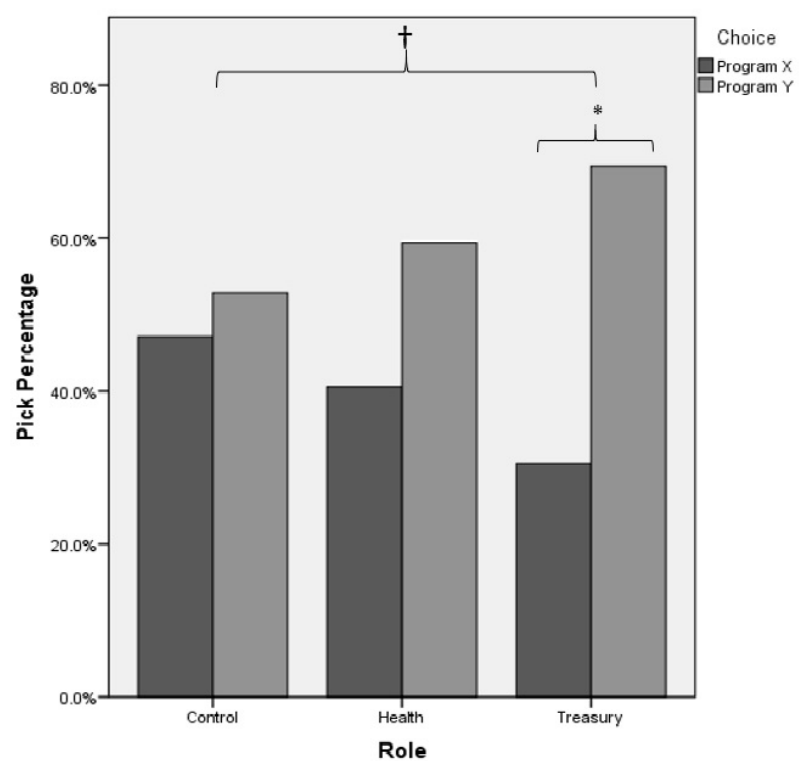
Figure 1. Program Choice Percentage. Figure depicting the percentage of participants who chose each program within each role. *p<0.001,